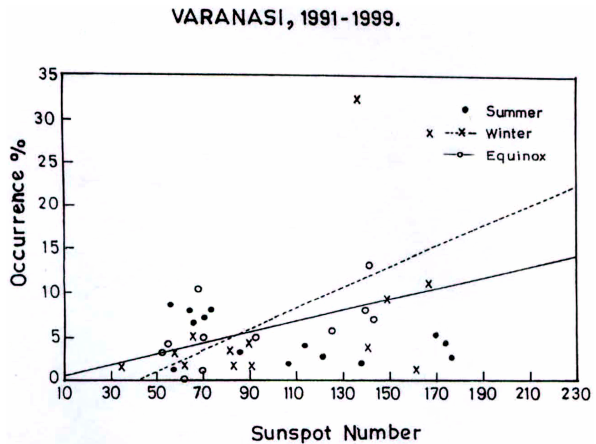
Fig. 5. Variation in scintillation occurrence rate with mean sunspot number for different seasons (summer, winter and equinox) during the years 1991–1999 is shown.